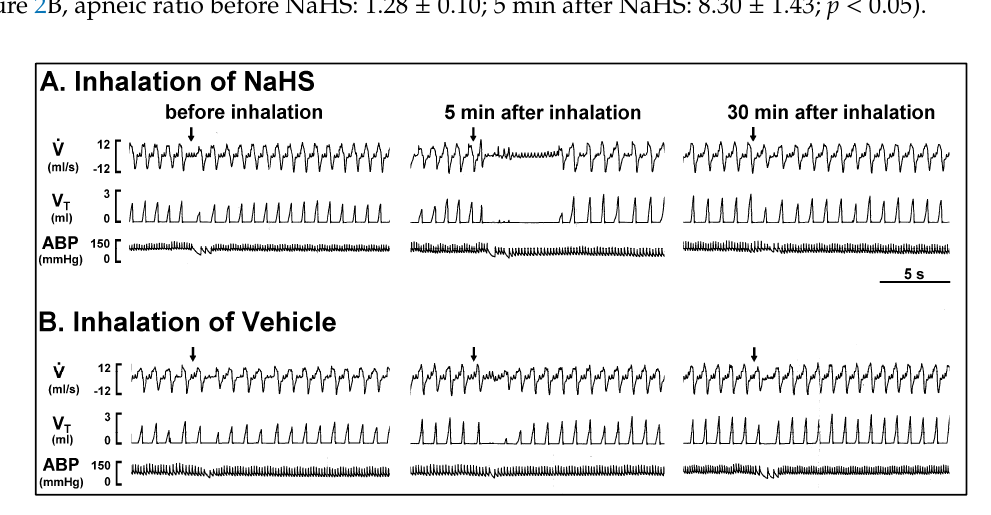
Figure 1. Experimental records illustrating the respiratory responses to a right-atrial bolus injection of capsaicin before, 5 min. after, and 30 min. after inhalation of sodium hydrosulfide (NaHS) ( A ) or its vehicle ( B ) in an anesthetized, spontaneously breathing rat (body weight: 320 g). NaHS (5 mg/mL) and its vehicle (isotonic saline) were delivered by aerosol inhalation for 3 min. An elapsed time of 20 min. was allowed between two inhalations. Right-atrial injections of capsaicin (1 μ g/kg) are indicated by the arrows. ˙V, respiratory flow; V T , tidal volume; ABP, arterial blood pressure. Please note that the apneic response elicited by the capsaicin injection was augmented by NaHS inhalation, but was not altered by vehicle inhalation.